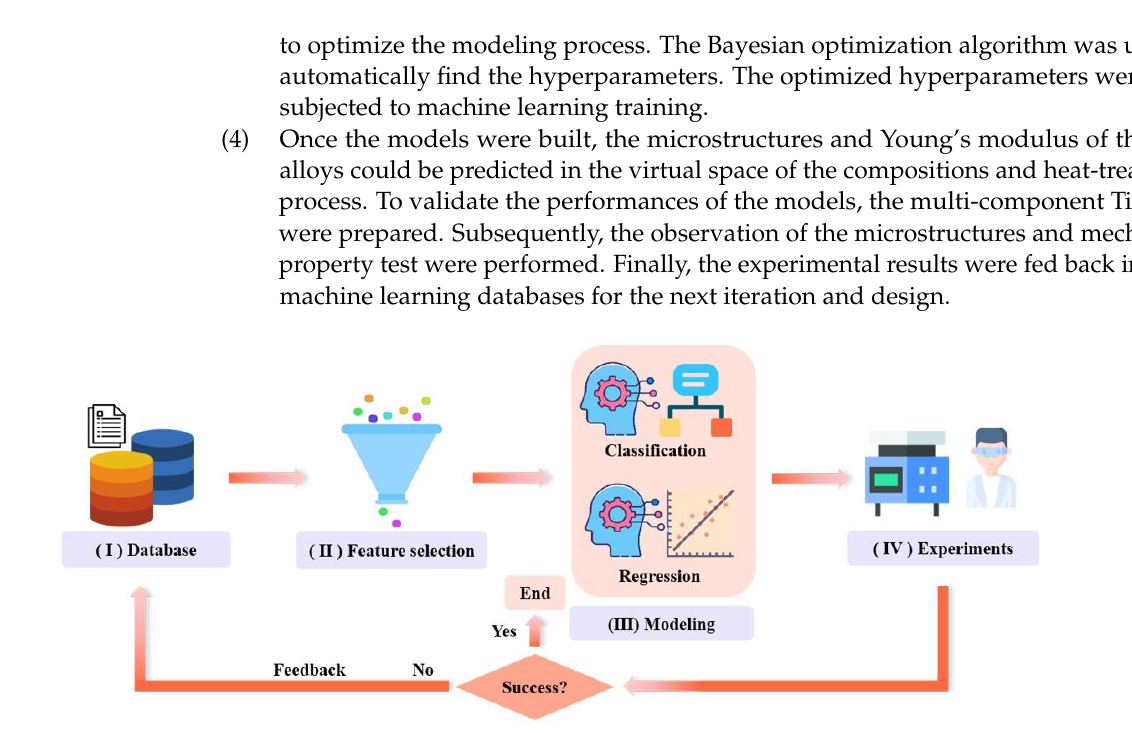
Figure 1. A machine learning prediction method to predict the microstructures and Young’s moduli of the biomedical multi-component β -Ti alloys.